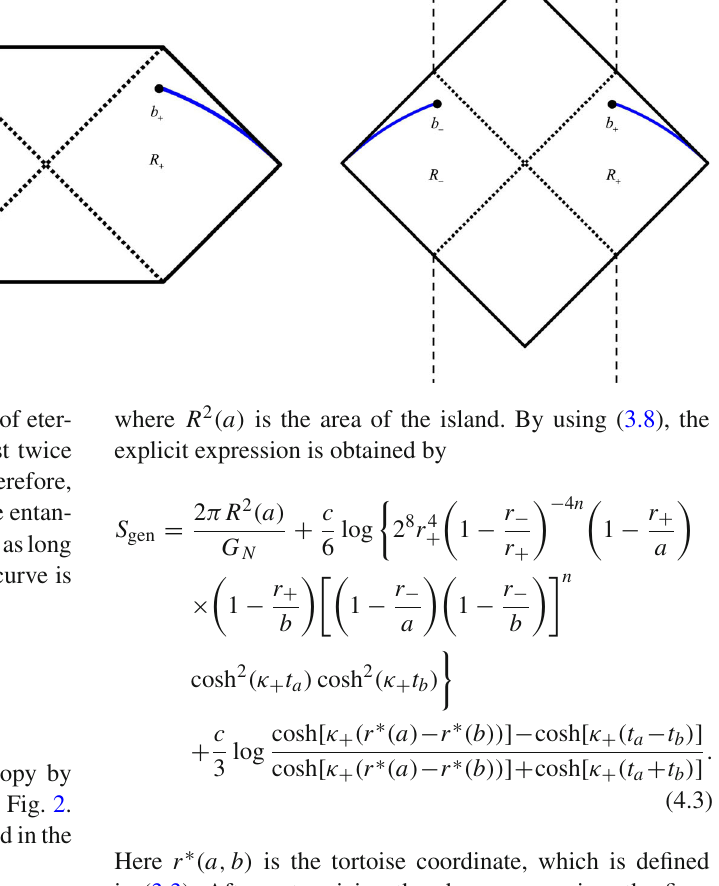
Fig. 1 Penrose diagram for GHS black holes without island. The left for 0 ≤ n < 1, while the right for n = 1. The Hawking radiation is emitted from the cut-off surface that denoted as b